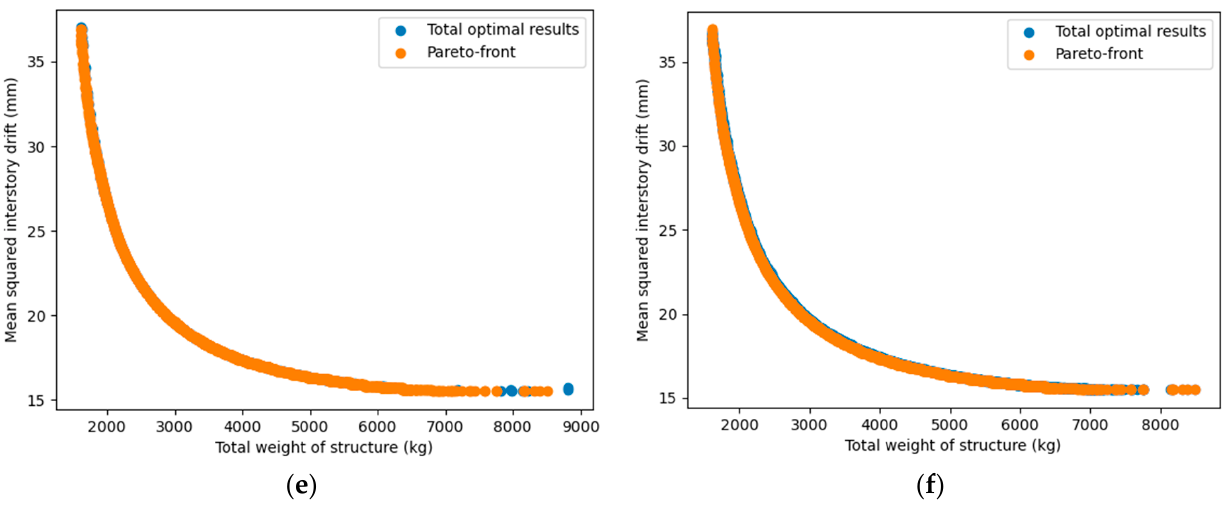
Figure 12. Paretal-front compared to the optimal solutions of the MOO algorithms in the 72-bar truss: ( a ) NSGA-II; ( b ) NSGA-III; ( c ) GDE3; ( d ) OMOPSO; ( e ) SPEA2; ( f ) MOEA/D.